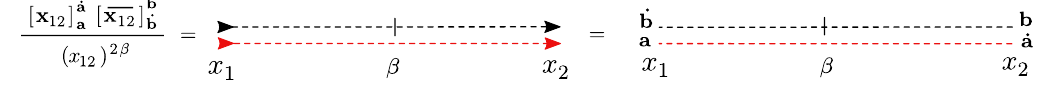
( u, x ) of (2.16) with conformal 1 − x 2 ‘ ˙ ‘